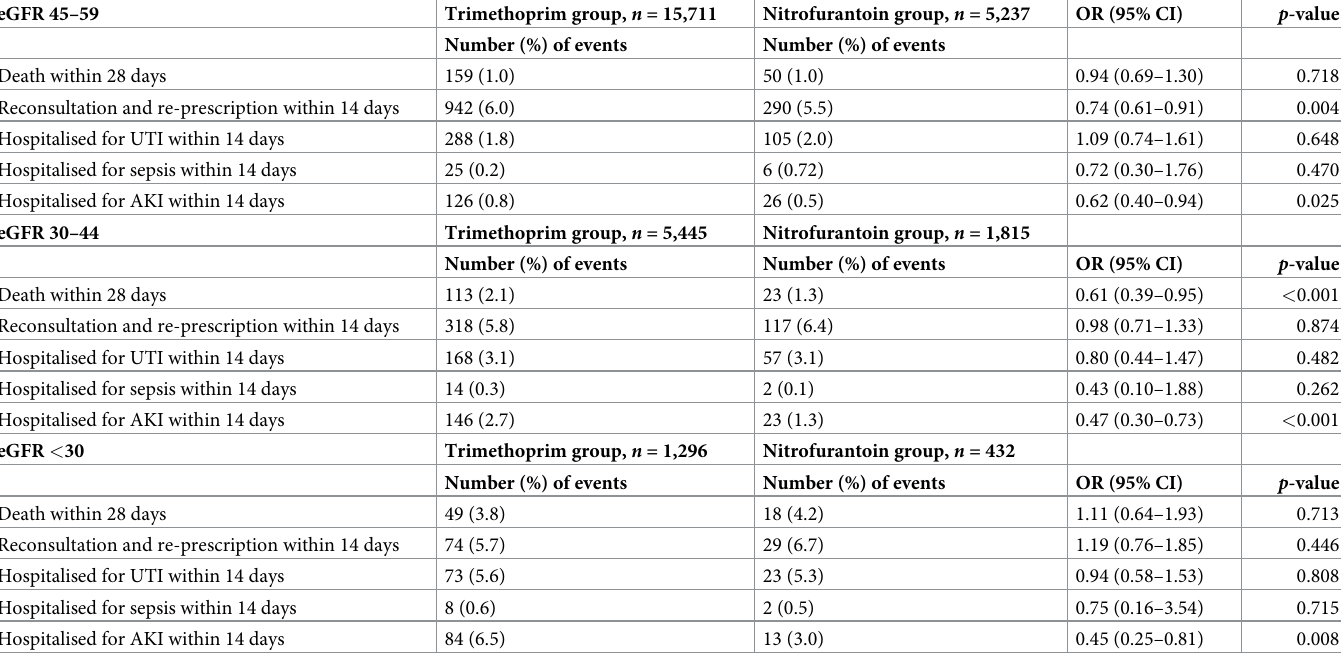
Table 4. ORs and 95% CIs for each outcome in propensity-score (cid:3) matched trimethoprim versus nitrofurantoin groups, across three eGFR